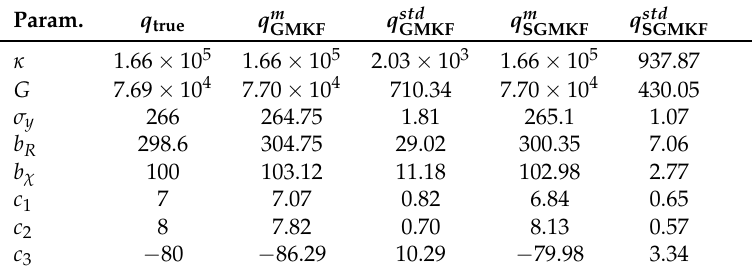
Figure 9. Isotropic and kinematic hardenings- and local damage evaluation according to time[s]. Summarizing the results, the true values and the mean and variance of the estimated parameters are compared in Table 5. Table 5. The identified model